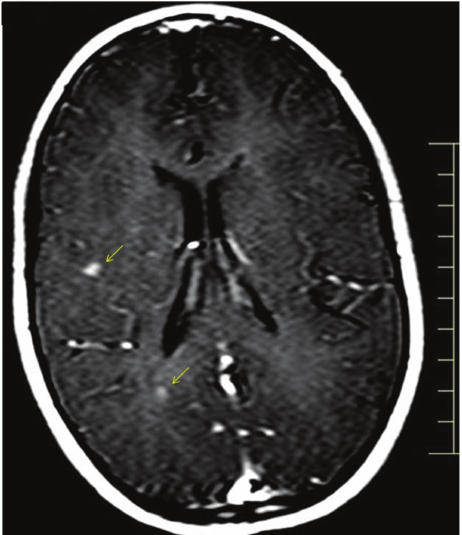
Figure 4: Brain MRI showing multiple gadolinium-enhancing lesions